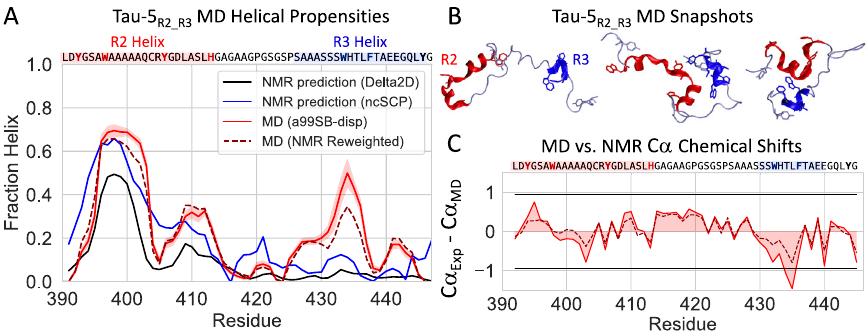
Fig. 1 | Molecular dynamics simulations of the disordered Tau-5 R2_R3 region of theandrogenreceptorN-terminaltransactivationdomain.A Comparisonofthe helical propensity observed in the 300K replica of a 74 μ s explicit solvent REST2 MD simulation of Tau-5 R2_R3 in its apo form (red), the helical propensity obtained after maximum-entropy reweighting of the MD ensemble using NMR C α chemical shiftsasrestraints(discontinuousline,darkred)andhelicalpropensitypredictions derived from experimental NMR chemical shifts (blue and black). Helical propen- sities were calculated with the DSSP algorithm. Simulated helical propensities are